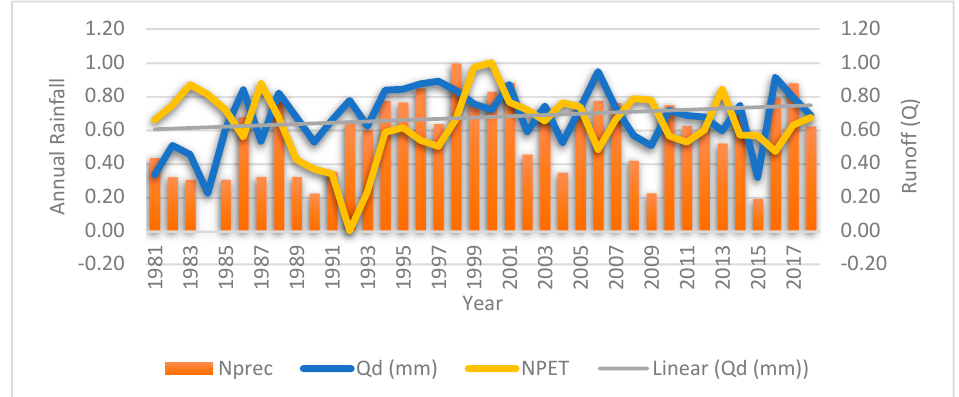
Figure 8. Annual rainfall dynamics in relationship to discharge and potential evapotranspiration (PET) (where Nprec is normalized precipitation, Qd is discharge, and NPET is normalized potential evapotranspiration).